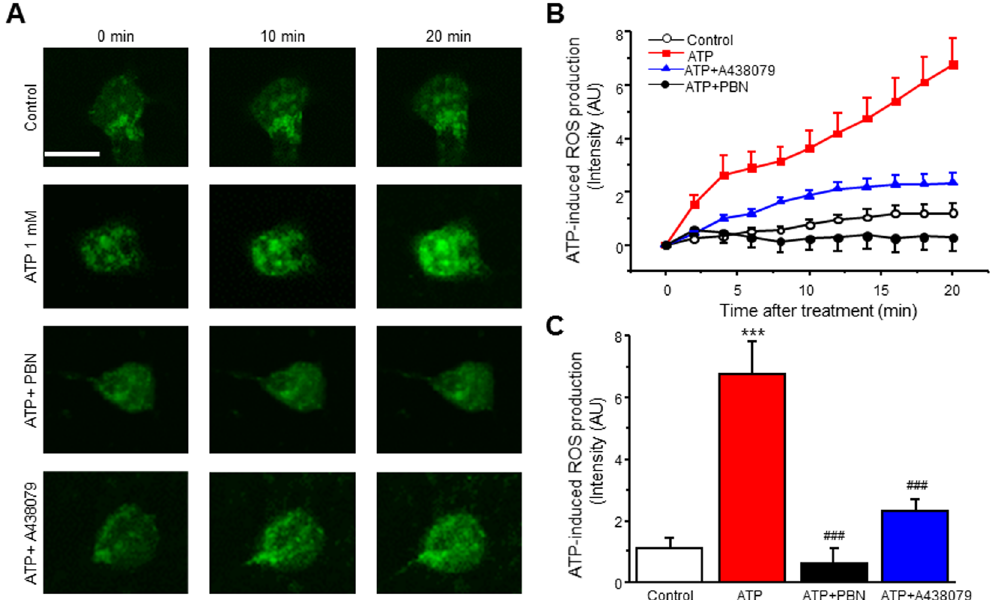
Figure 1. ATP induces ROS increase in spinal cord dorsal horn (SCDH) neurons. ( A ) Representative of live cell confocal images captured before (0 min) and after application of 1 mM ATP in the presence of vehicle, PBN or A438079. ( B ) Time lapse of ROS production after ATP (1 mM) administration in the presence of vehicle, PBN or A438079. ( C ) Summary of the effects of PBN or A438079 on ATP-induced ROS production. Values represent mean ± SEM, n = 11–12 neurons. *** P < 0.01 compared to control, ### P < 0.001 compared to ATP group by the one-way ANOVA. Scale bar 10 µ